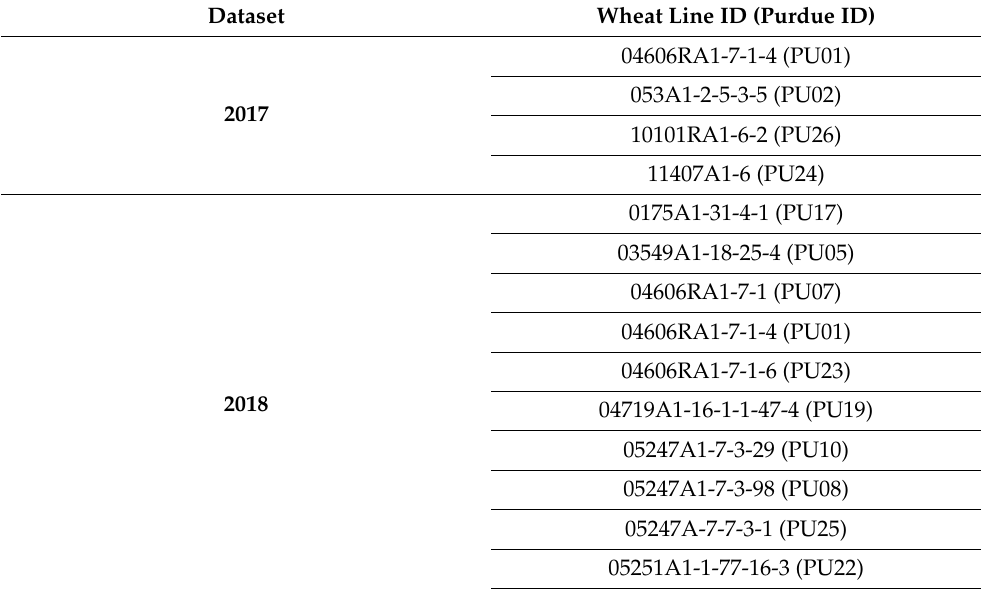
Table A2. List of wheat winter lines used in both years of experiments with respective yield